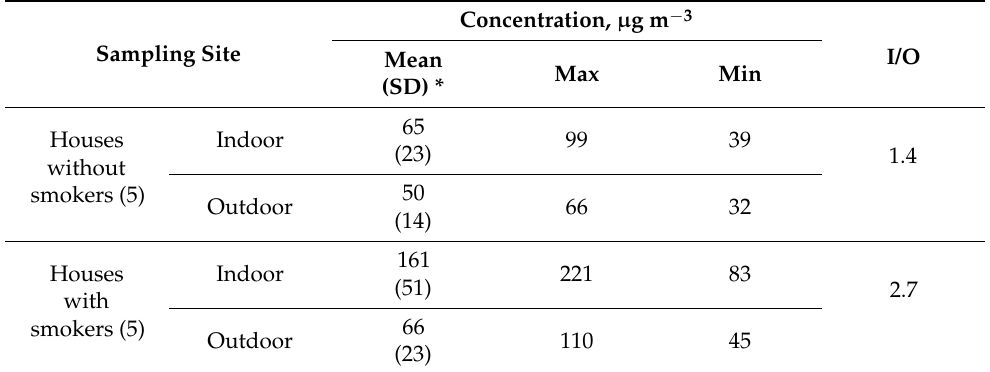
Table 3. Concentration of PM 4 indoors and outdoors for the single-family houses without and with smoking residents in